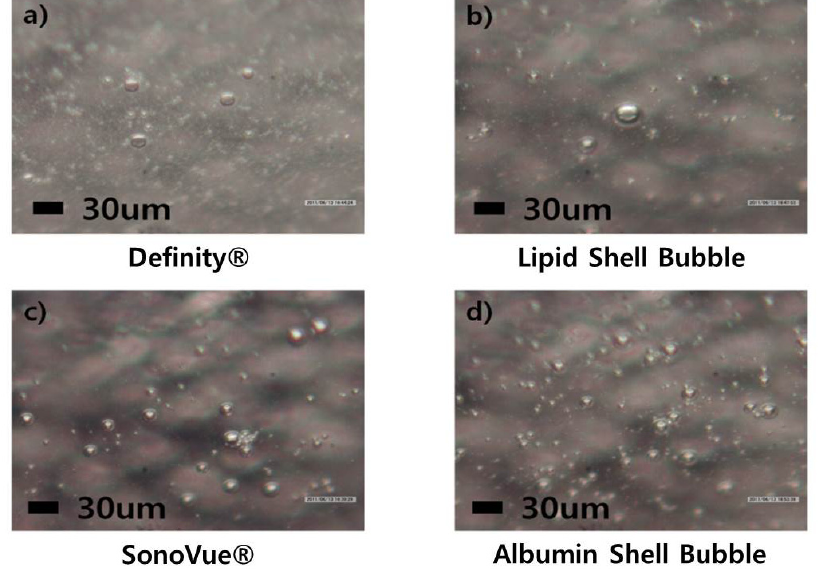
Figure 3. 3D tomographic images of the UCAs. In order to confirm round shape microbubbles, 3D optical images were obtained at 400×